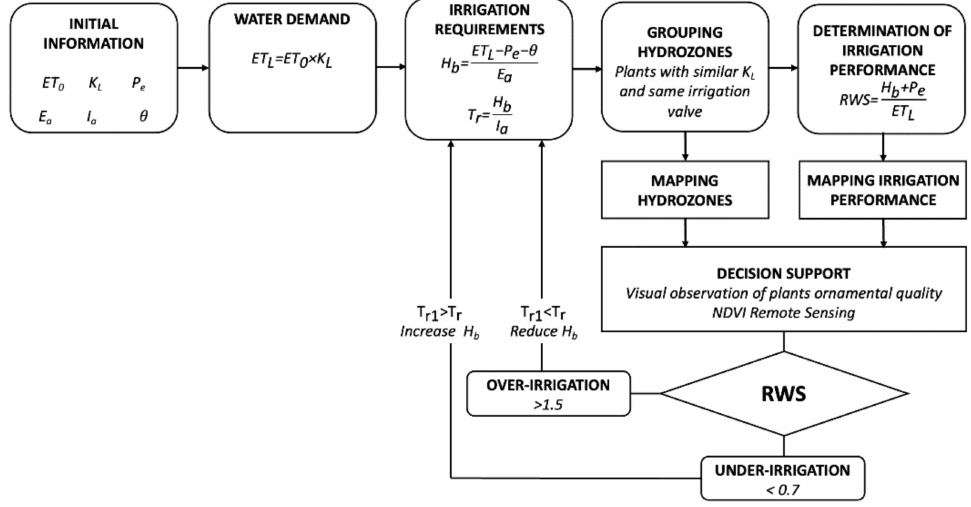
Figure 1. Diagram of the irrigation assessment and management approach for large urban